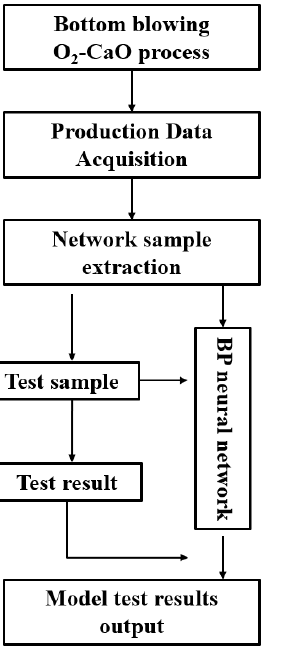
9 of 18 Figure 5. Schematic diagram of BP neural network structure.